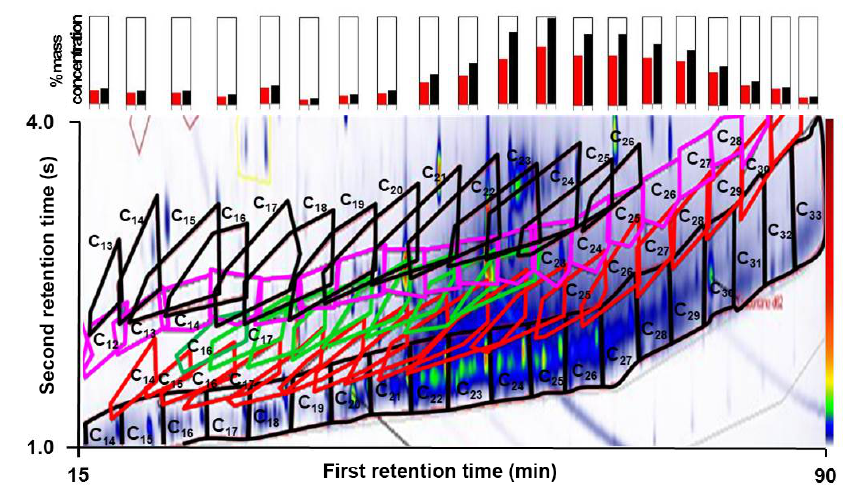
Figure 1. A GC × GC chromatogram (contour plot) indicating homologous series of compounds identified in diesel engine exhaust emis- sions. Emissions from a light-duty diesel engine operating at 1800 revolutions per minute and 1.4 bar brake mean effective pressure. Com- pounds identified in the contour plot are indicated by the coloured polygons – lower black polygons are n + i -alkanes; red polygons are monocyclic alkanes; green polygons are bicyclic alkanes; pink polygons are aldehydes + ketones; and upper black polygons are monocyclic aromatics. Each peak in the contour plot represents a compound present in the emissions; warmer colours (e.g. red) are more intense peaks while colder colours (e.g. blue) are smaller peaks. The contour plot were produced by GC Image v2.5. The bar charts above the contour plot show the volatility distribution of total alkanes (red) and total identified species (black), indicating that the majority of the emissions consist of alkanes. For details of the compound attribution method, see Alam et al. (2017).